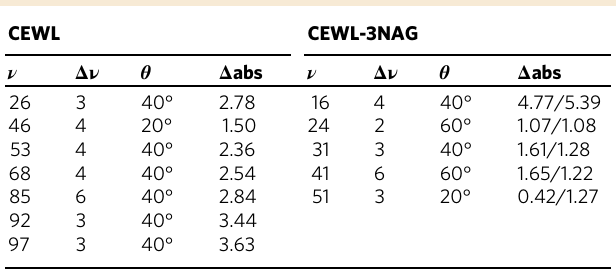
Table 1 PV-ATM Δ abs peaks from CEWL and CEWL-3NAG crystal measurements CEWL